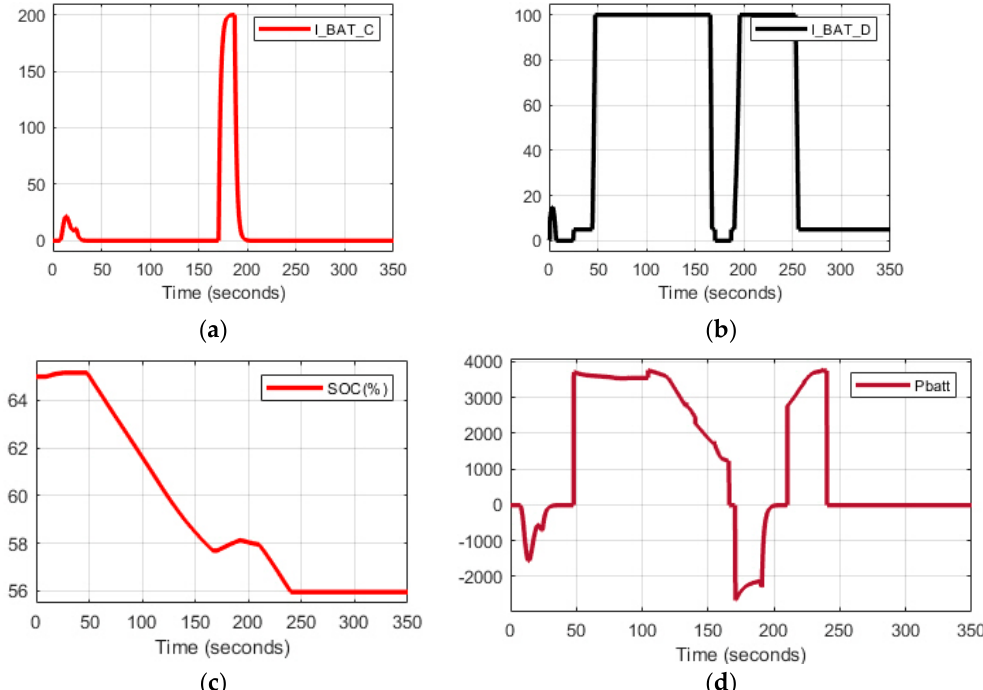
Figure 17. ( a ) Battery charging current, ( b ) battery discharging current, ( c ) battery SOC%, ( d ) battery power.